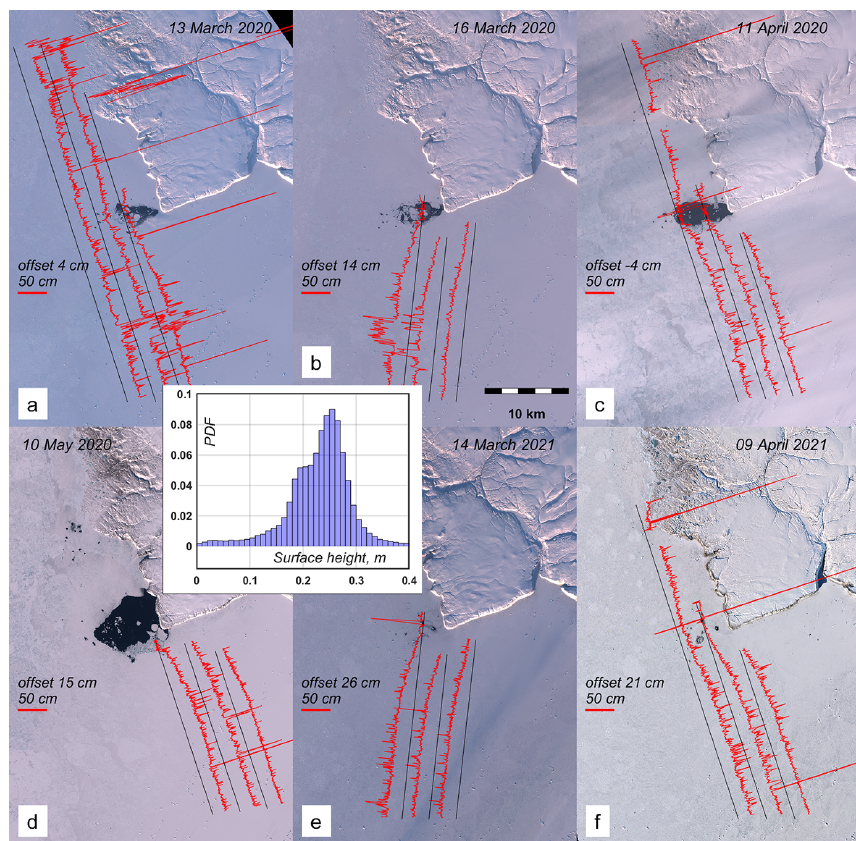
Figure 3. The ATL07 elevations (red lines) from three strong beams overlaid on Sentinel-2 images of the polynya in March–May 2020 and in March–April 2021. The elevations are adjusted to the sea level in the polynya and plotted as absolute deviations from the ground tracks (black lines) in a direction normal to the tracks. The open water was used as a reference level to calculate the corresponding offsets for each subset. The red scale bar in each panel corresponds to 50cm elevation. The inset histogram demonstrates the probability distribution of all heights shown in (a) – (f)